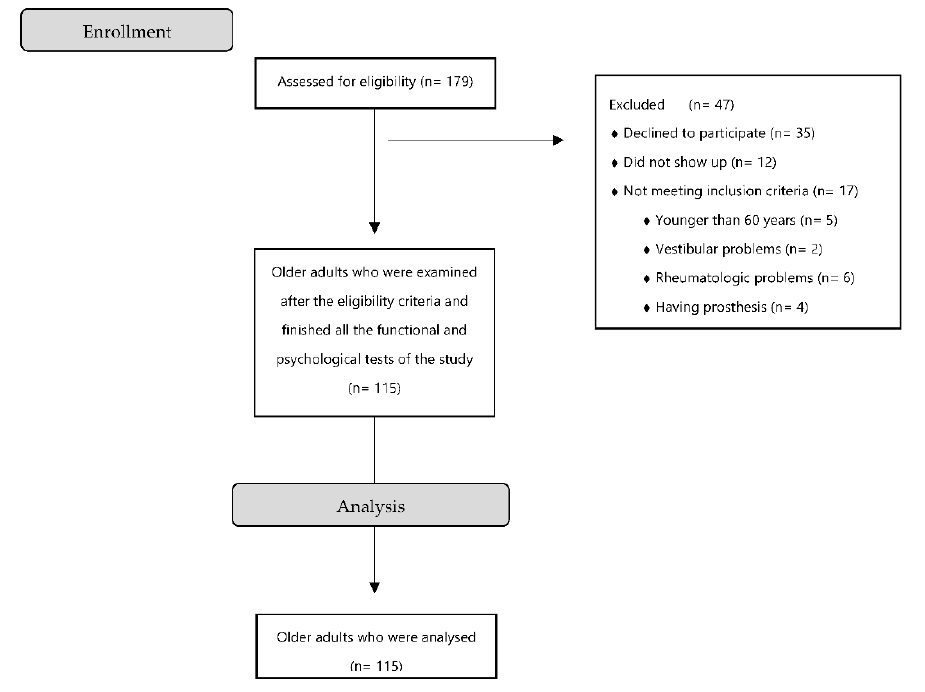
Figure 1. Flow diagram of study participants.